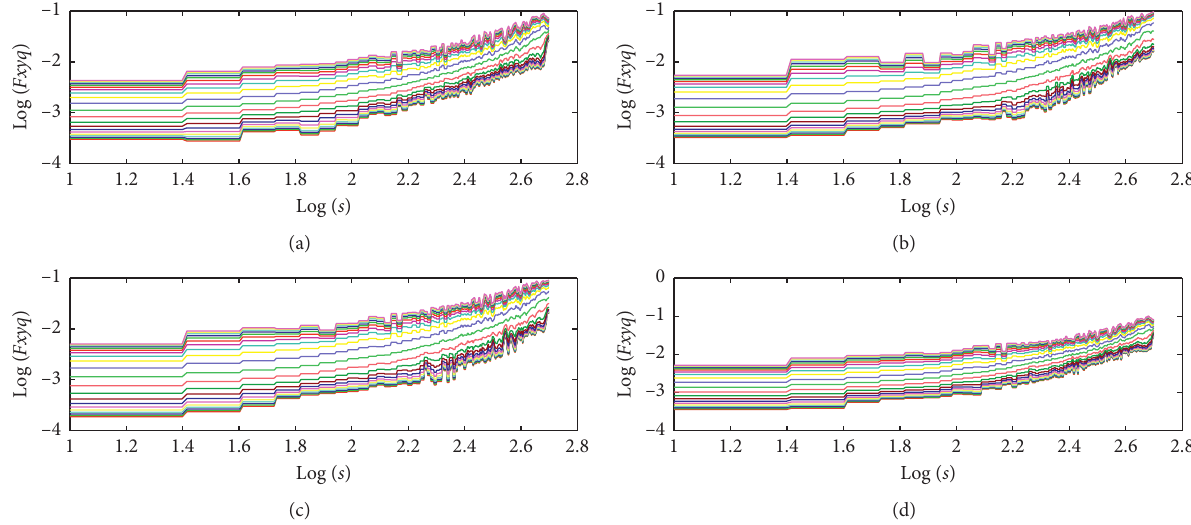
Figure 7: Log-log plots of cross-correlation fluctuation function versus time scale s for market participation willingness and Chinese stock market returns volatility. (a) SME. (b) SSE50. (c) CSI300. (d)